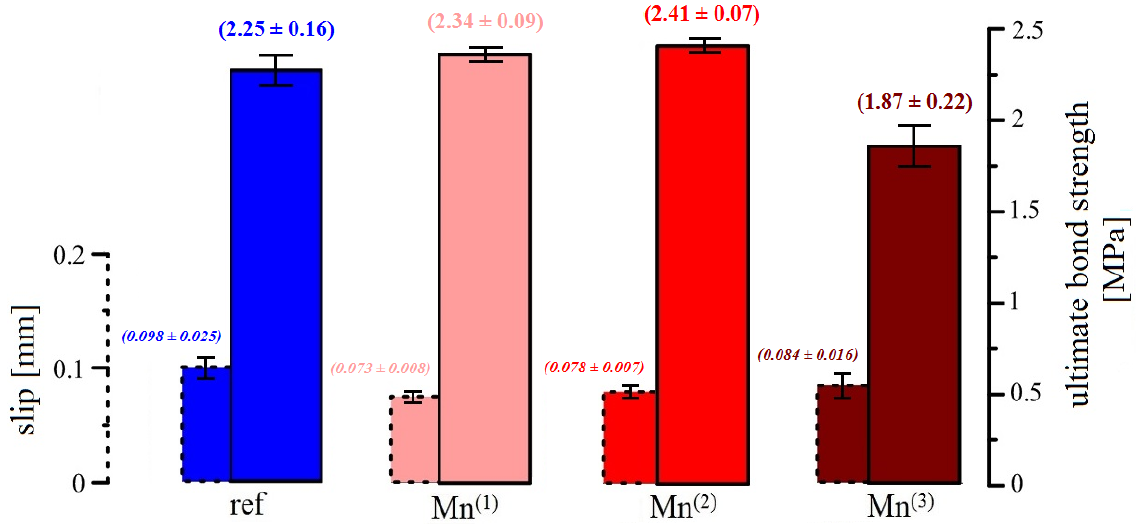
Figure 10. Summary bar chart of bond strength and load-displacement results.